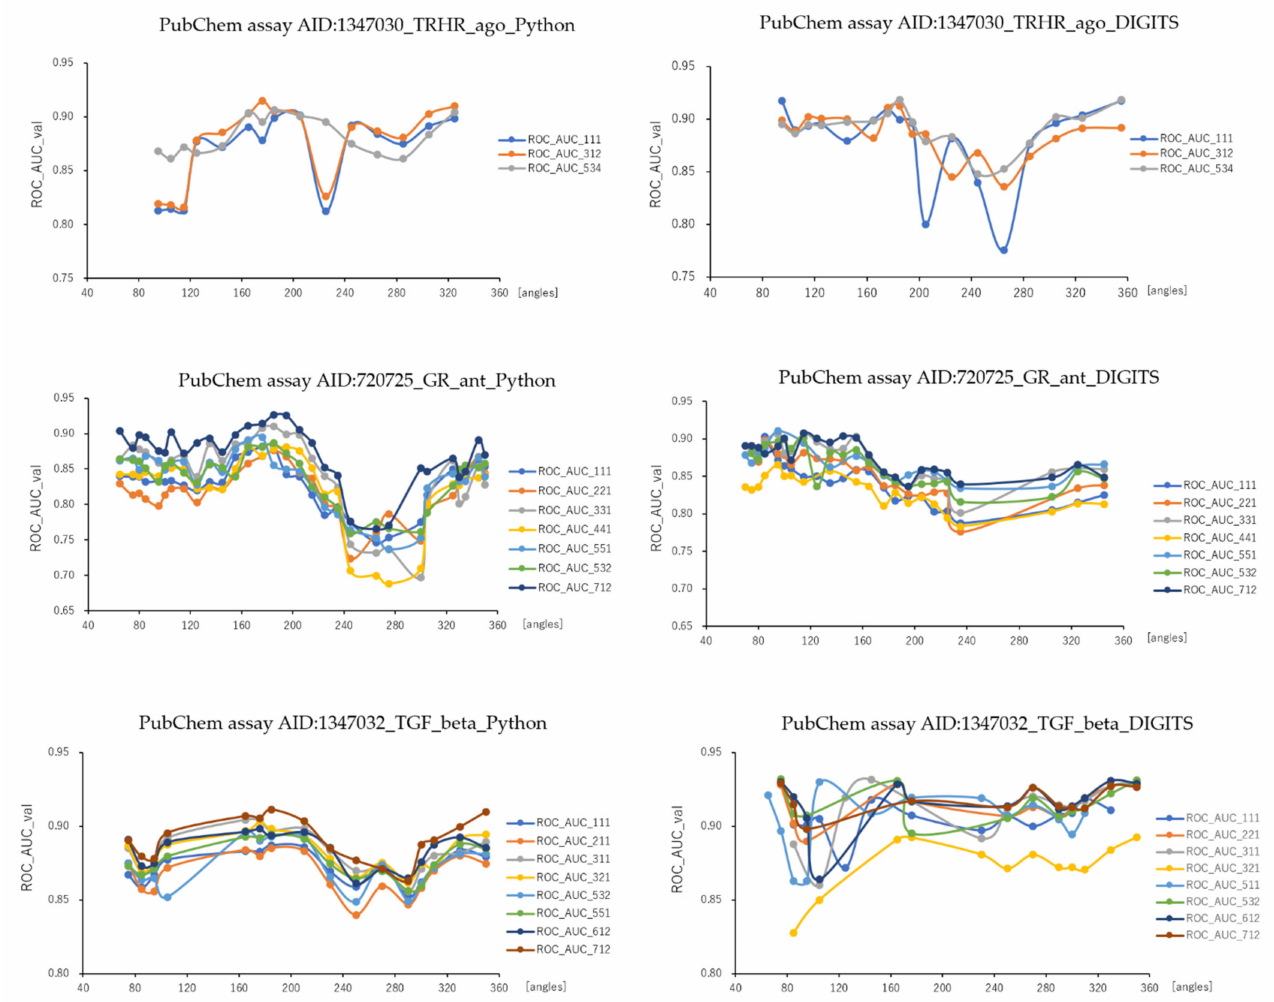
Figure 1. ROC_AUC with angles in DeepSnap-DL using TensorFlow and DIGITS of prediction models of the glucocorticoid receptor (PubChem assay AID:720725_GR_ant), TGF-beta/Smad (Pub- Chem assay AID:1347032_TGF_beta_ant), and agonist of the thyrotropin-releasing hormone receptor (PubChem assay AID:1347030_TRHR_ago) in the validation dataset; n =